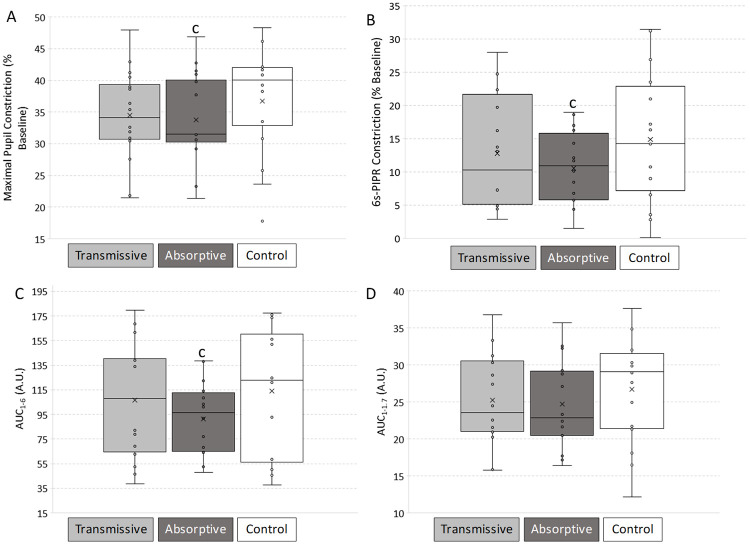
Biological validation of filtered lights (N = 16).Pupillary Light Reflex (PLR) parameters calculated under light filtered with uncoated (used as control), transmissive and absorptive states: A) Maximum pupil constriction, with respect to the baseline; B) post-illumination pupil response 6 seconds after the end of the 1-s light stimulus (6s-PIPR), expressed as % constriction respect to baseline; C) Area Under the Curve from 1 to 6 seconds from the beginning of the light stimulus (AUC1-6) and D) Area Under the Curve from 1 to 1.7 seconds from the beginning of the light stimulus (AUC1-1.7) both calculated from baseline (100%). Repeated measures ANOVA with Bonferroni post-hoc was performed. ‘c’ indicates significant differences with uncoated control filter (p < 0.05).